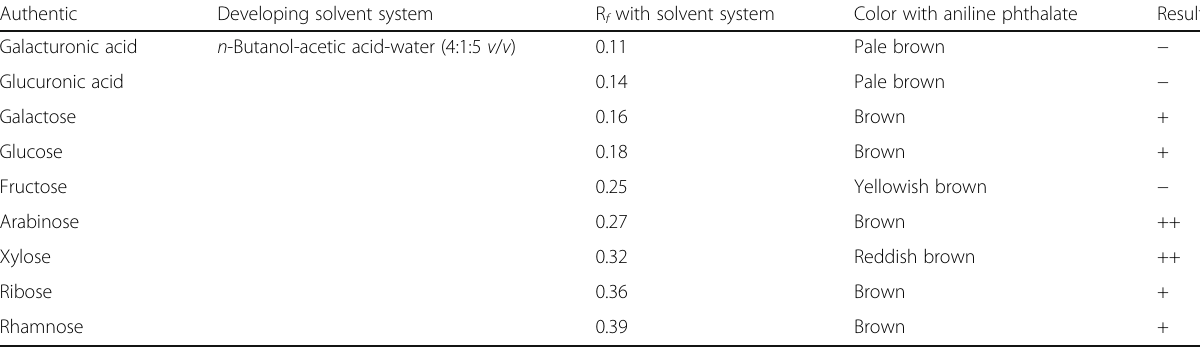
Table 1 PC analysis of mucilage hydrolysate in the aqueous extract of P . ovata seeds